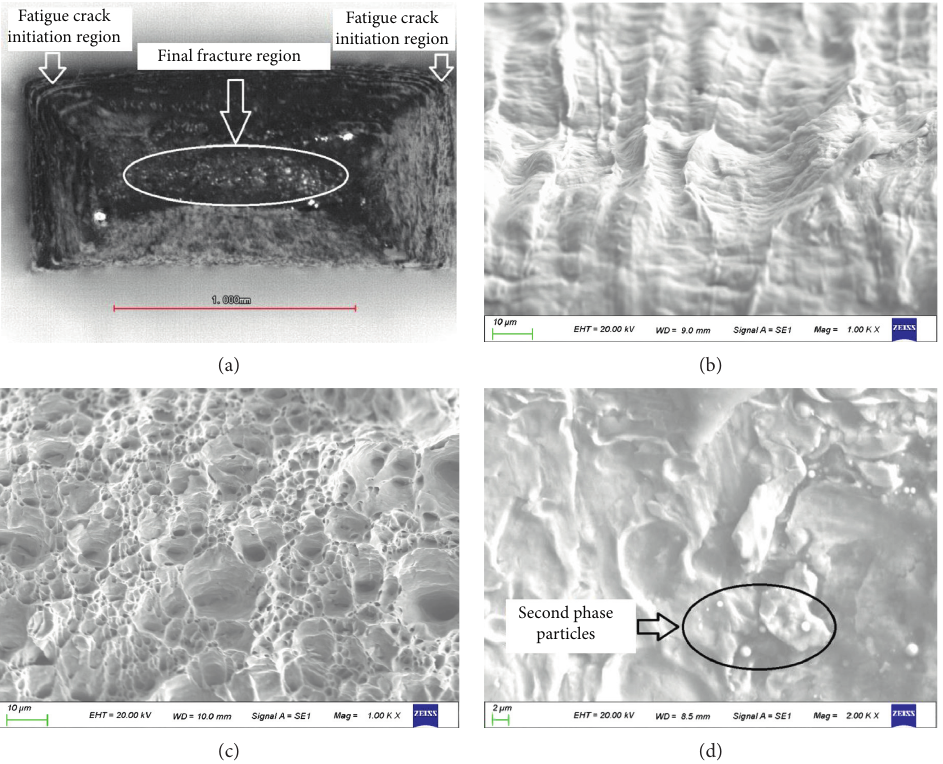
Figure 6: Macro- and micromorphology of fatigue fracture. (a) The macroscopic morphology of the fatigue fracture. (b) The fatigue crack propagation region (1000X). (c) The final fracture region (1000X). (d) The final fracture region wider. Conversely, the smaller the Δ α value, the smaller the process. The larger the Δ α value, the wider the range of height fluctuation range. The specimen surface is flat, and height fluctuation. At this time, the surface of the specimen the multifractal spectrum becomes narrower. fluctuates violently, and the multifractal spectrum becomes